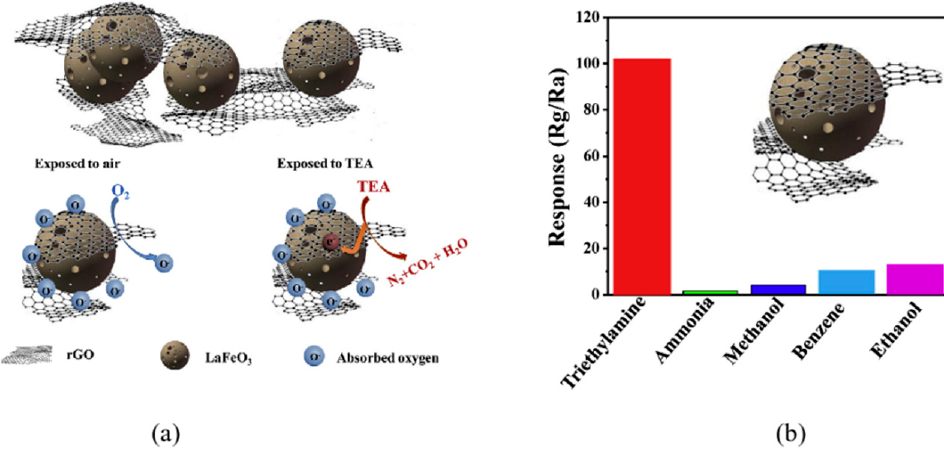
Figure 23. ( a ) The nanostructure and the possible gas-sensing mechanism of the RGO/LaFeO 3 . ( b ) The response of LaFeO 3 , RGO/LaFeO 3 to 100 ppm of five different VOCs at 240 °C [144]. In recent years, spinel structures have also been used in TEA gas detection because of their good thermal stability and sensitivity to VOCs [145,146]. The common formula for normal spinel structures is A tetra (B 2 ) octa O 4 where A is the distribution of positive second- order metal cations in tetrahedral voids, and B is the distribution of positive trivalent metal cations in octahedral voids [147]. The common formula for inverse spinel structures is B tetra (AB) octa O 4 . The distribution of A and B is just the opposite of that formal spinel structure [148]. The different cation spices and charge states of two sites in the polyhedral crystalline structure will significantly affect the physicochemical properties of nano- materials [149]. Ma et al. [150] prepared hierarchical spinel-type corn-like MGa 2 O 4 (M = Ni, Co) architectures using a facile hydrothermal method and subsequent calcination. Subsequently, they completely and scientifically investigated the phase compositions and microstructures, which may be the essential influence factor of excellent gas-sensing prop- erties. Yang et al. [151] investigated the impact of the calcination temperature on the mor- phology and TEA-sensing properties of NiCo 2 O 4 microsphere nanomaterial. The experi- ment results reveal that the material shows good selectivity to TEA but that its high work- ing temperature and slow response time need to be improved. The synthesis process and calcination results of NiCo 2 O 4 micromaterials are displayed in Figure 24. Figure 24. The synthesis process of NiCo 2 O 4 nanospheres annealed at various temperatures [151]. The comparison of gas-sensing characteristics of nanomaterials listed in this paper will be given in Table 3 at the end of this section.